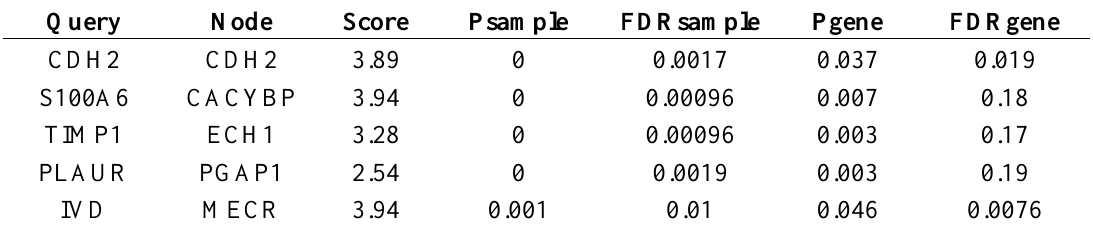
Table 3. Differentially activated networks containing genes previously implicated in OS metastasis.